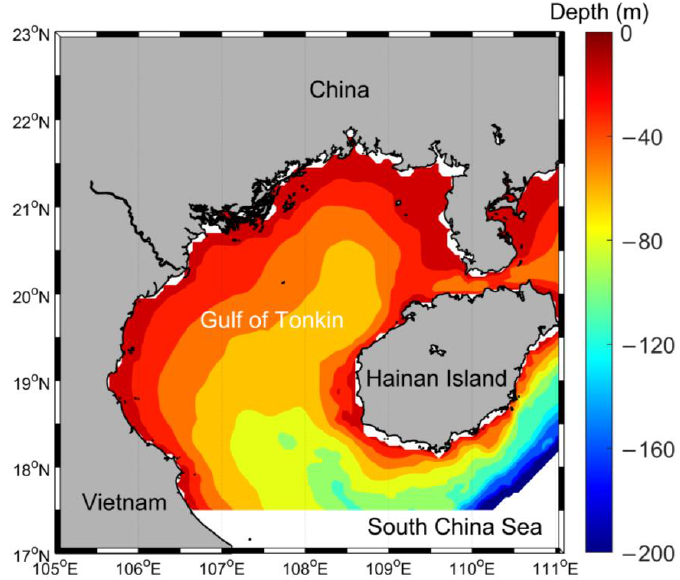
Figure 1. Topography of the Gulf of Tonkin, based on ETOPO1 dataset [21].